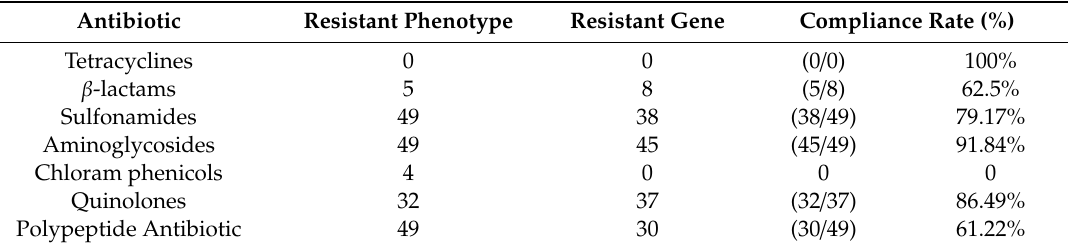
Table 5. Drug-resistant phenotype and genotype coincidence rate of T. halophilus. Antibiotic